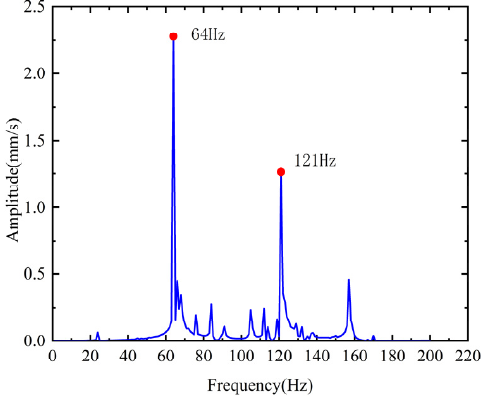
Figure 8. Torsional vibration characteristic curve .